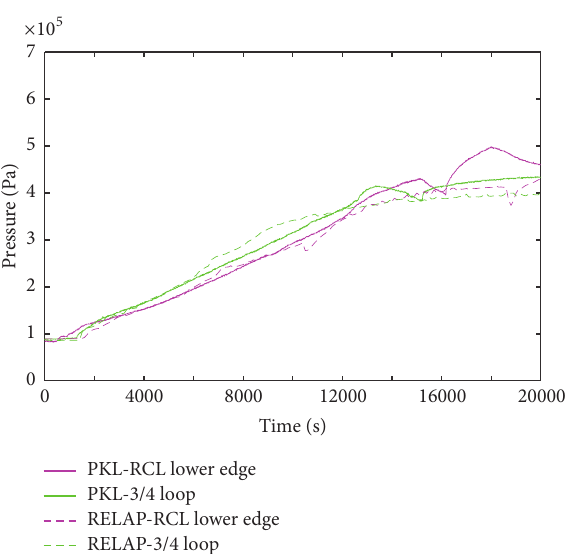
Figure 5: Pressure. PKL versus RELAP5. Level influence. Phase I.